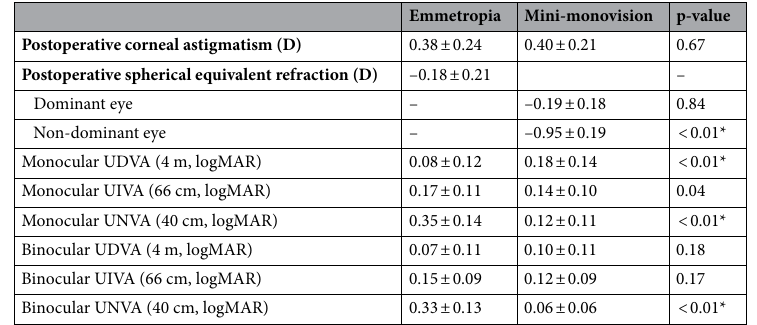
Table 2. Refractive and visual outcomes in patients bilaterally implanted with the Eyhance ICB00 intraocular lens at 3 months postoperatively. Data are expressed as mean ± standard deviation. D diopter, logMAR log of the minimum angle of resolution, UDVA uncorrected distance visual acuity, UIVA uncorrected intermediate visual acuity, UNVA uncorrected near visual acuity. *Statistically significant values are marked with an asterisk (p <